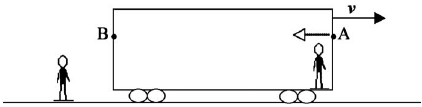
FIG. 1. The exercise (cid:1) following Halliday et al. , Ref. 14